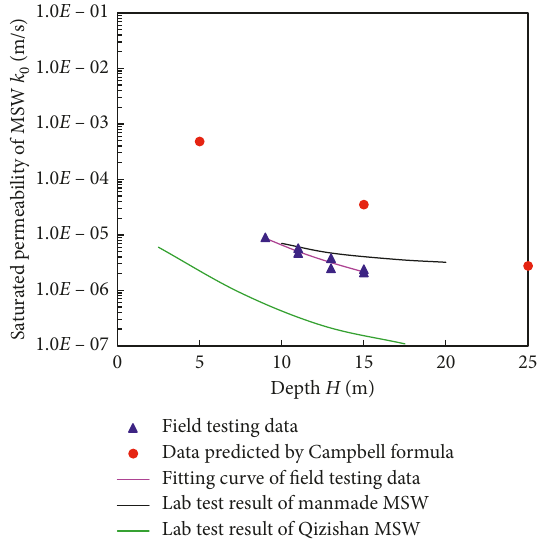
Figure 1: Saturated permeability distribution of Qizishan landfill in the spatial domain [18,